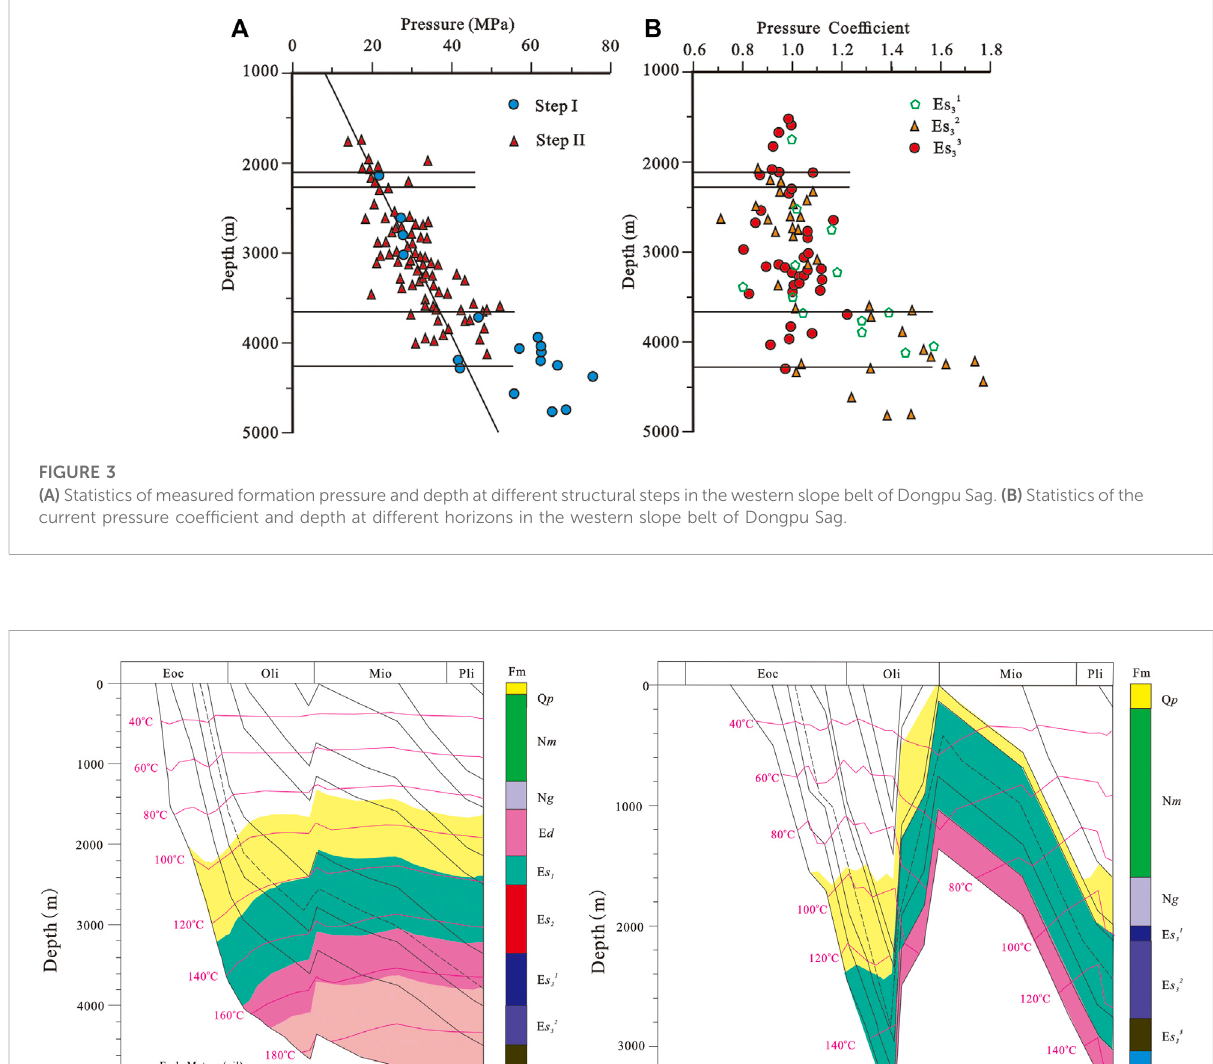
thickness, absolute age, vitrinite re fl ectance, and measured borehole temperature data. Well completion reports (e.g., DST data) from the SINOPEC Zhongyuan Oil fi eld provide the measured R o and borehole temperature values (Figure 3).